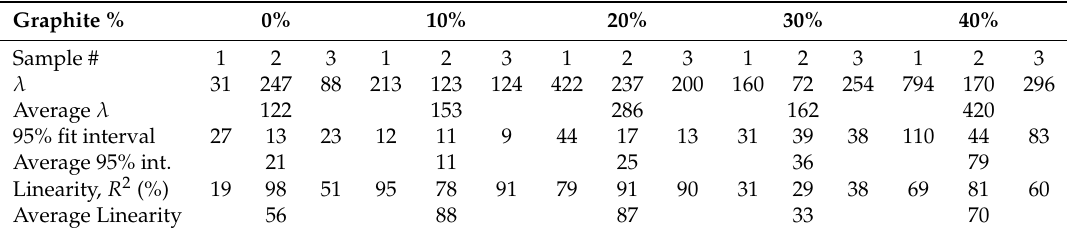
Table 2. Experimental results from the electromechanical tests, where λ is the gauge factor, R 2 is the coefficient of determination, and 95% fit interval is the interval that contains 95% of best fitting data